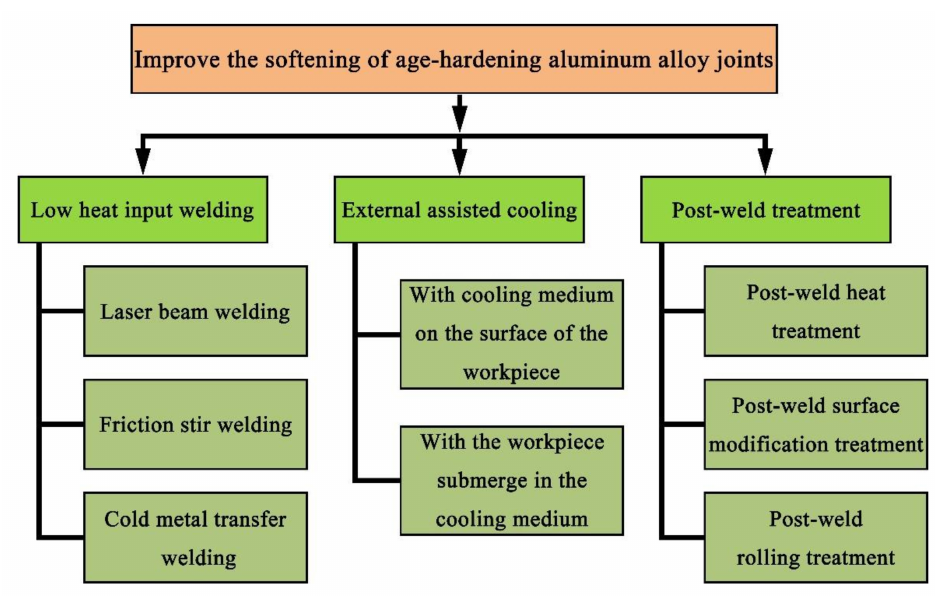
Figure 5. Outline of research based on reducing joint